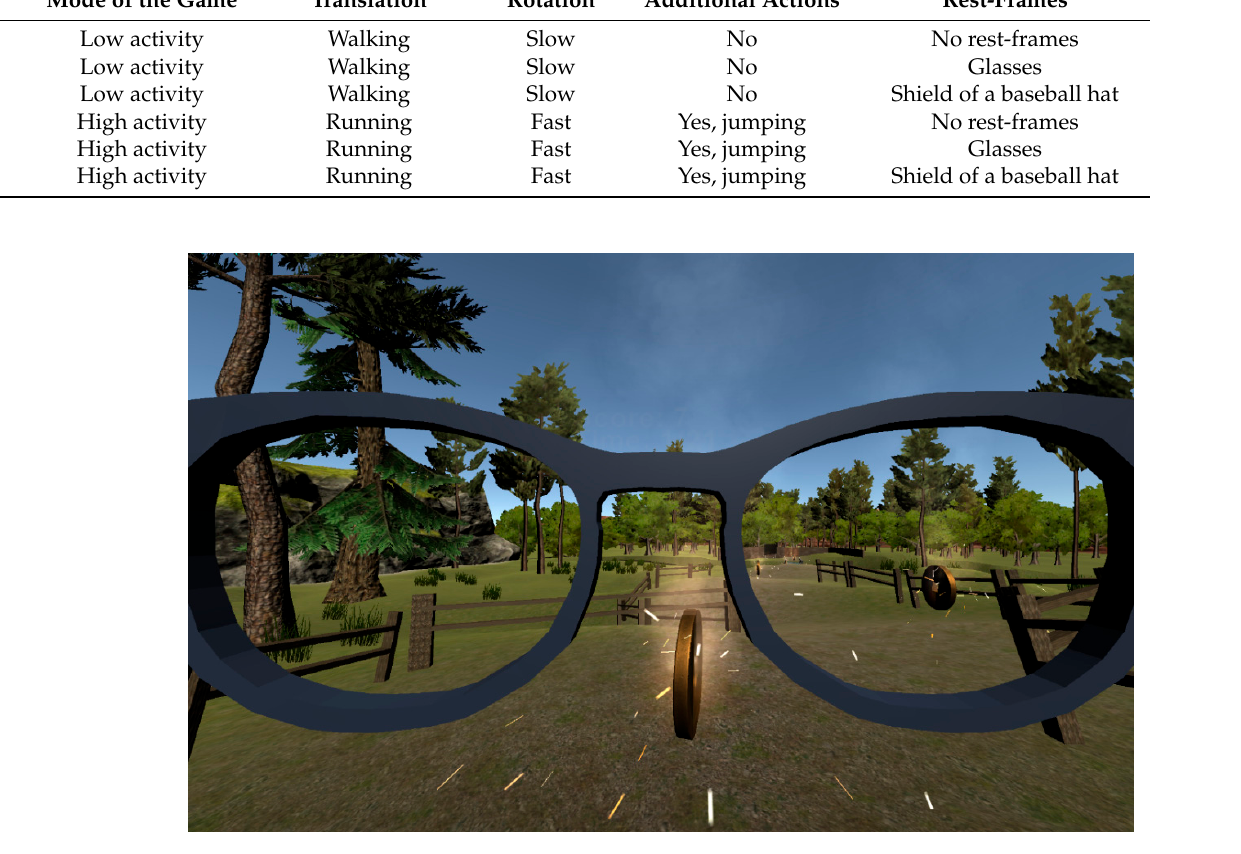
Figure 1. The forest scene in low action (LA) mode game with glasses as a head-centric rest-frame. Golden coins are set on the player’s height, so there is no need to jump to collect them.